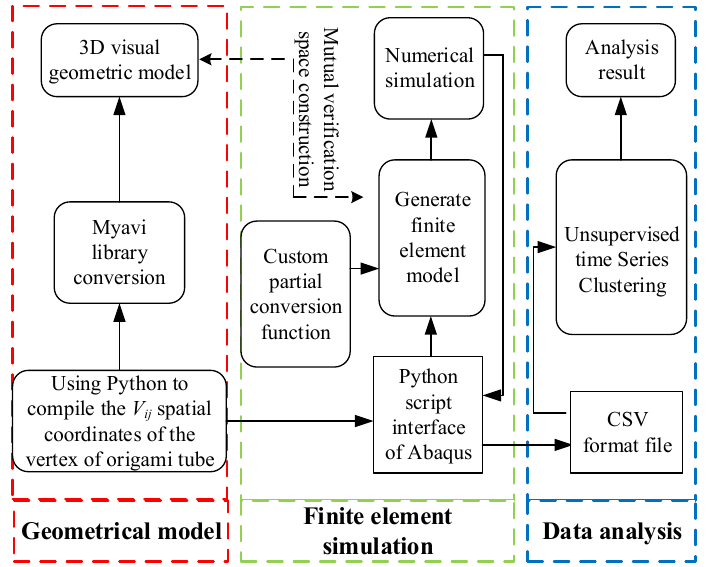
Figure 1. Analytical methods for origami tubes with polymorphic patterns: geometric modeling, finite element modeling and data analysis.